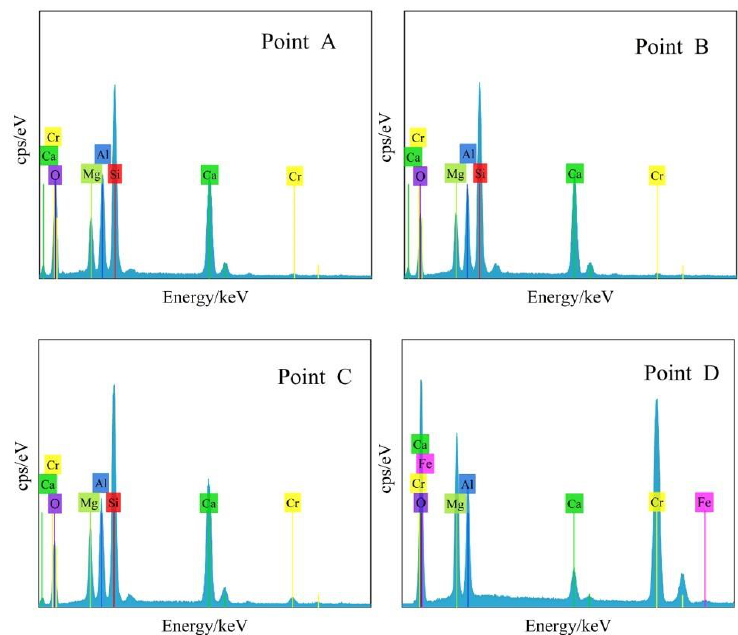
Figure 8. EDS spectra of points A, B, C, and D.